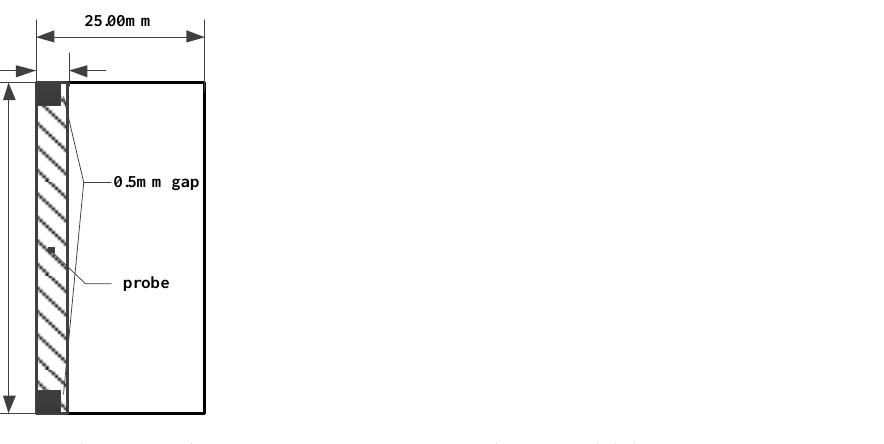
Figure 2. Two-dimensional axisymmetric COMSOL simulation model diagram.